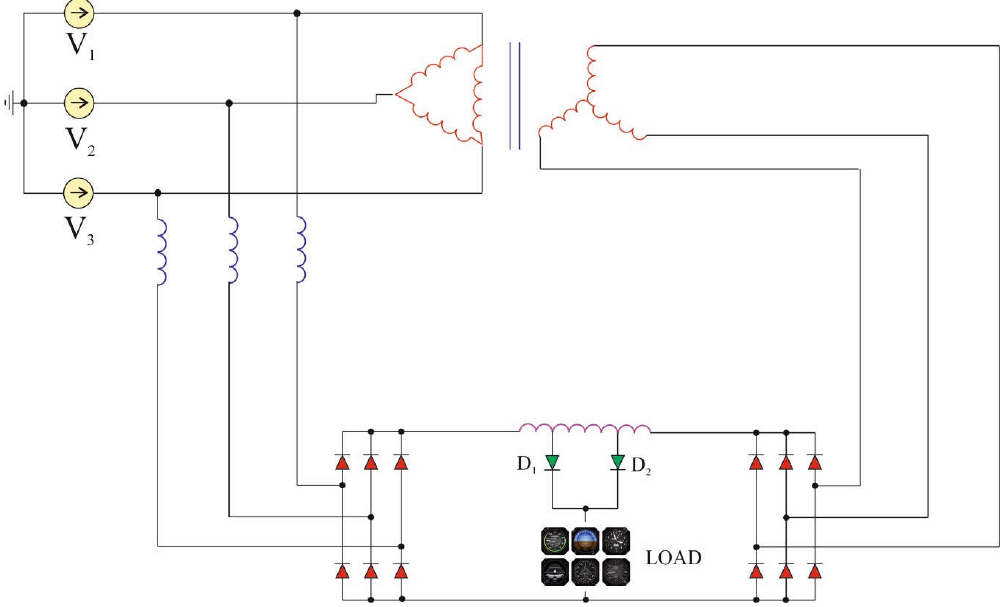
Figure 2. Diagram of a classic 24-pulse rectifier powered by a three-phase transformer.